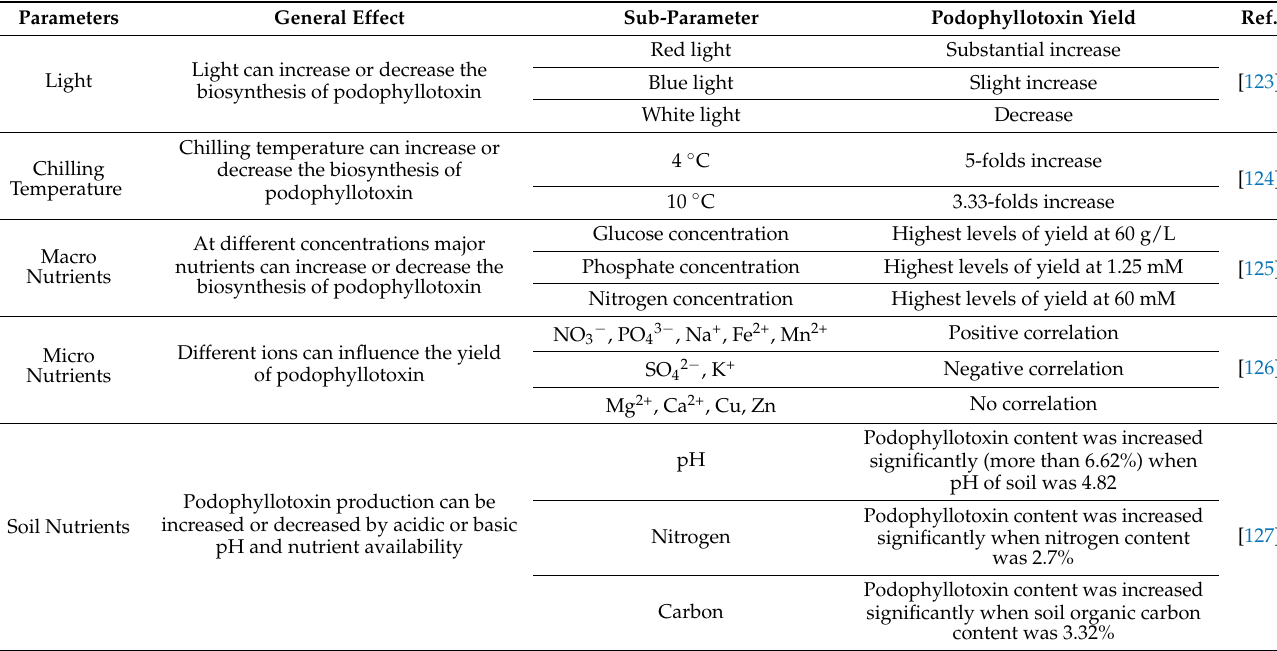
Table 3. The influence of varying parameters on yield of plant-biosynthesized podophyllotoxin.